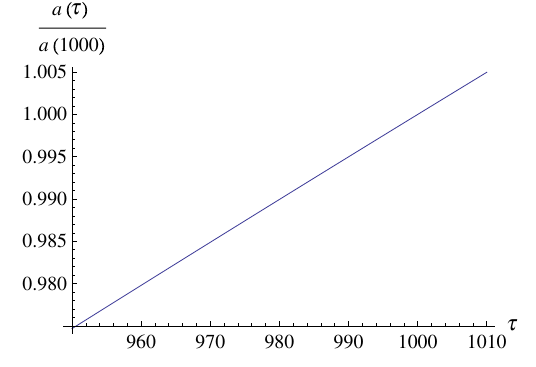
= 10 120 . We 3 H 2 0